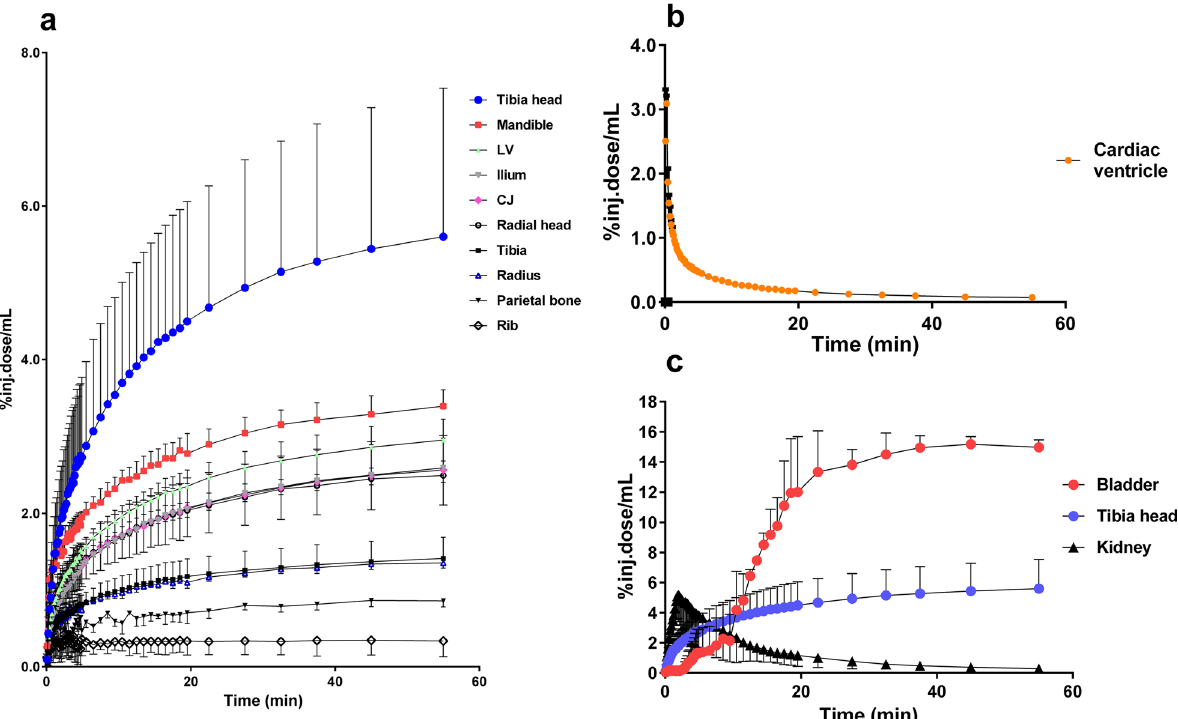
Fig. 2 a Time‑activity curves (TACs) obtained from VOIs of different rat bones. b The TAC of the left cardiac ventricle demonstrates the rapid clearance of [ 18 F]fluoride from blood. c Uptake in kidney and bladder represent excretion of [ 18 F]fluoride via the urinary tract; the TAC for the tibia shows an example of [ 18 F]fluoride uptake in the diaphysis of a long bone. LV mean SD, n ± =